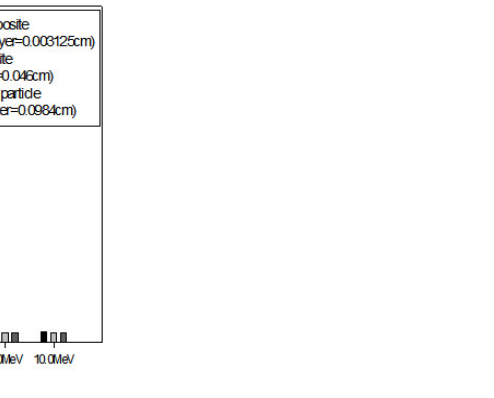
Figure 19. Linear attenuation coefficient of PE/tungsten composites according to composite struc- ture.